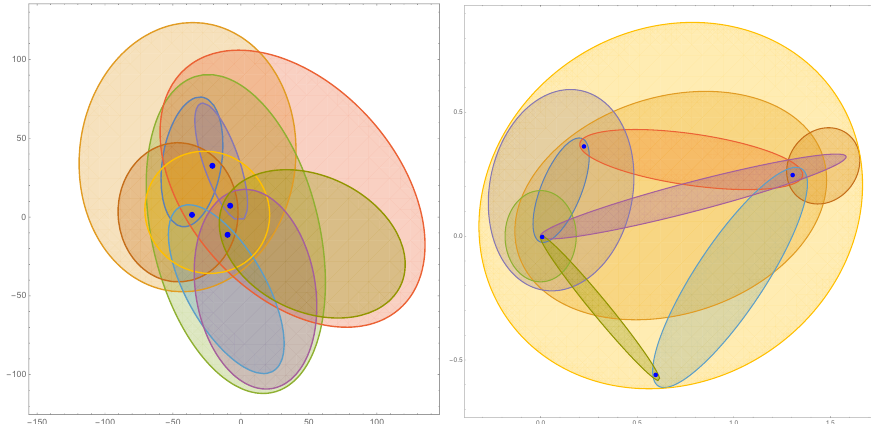
Figure 19. The singular E-surfaces from the two six-point one-loop integrals 1. 1L6P.VII (left) and 1. 1L6P.VIII (right) with di(cid:11)erent kinematics yielding drastically di(cid:11)erent maximally overlap- ping regions. In both cases our construction of the deformation is generated from the combination of four radial (cid:12)elds with sources indicated by blue dots. Additional support sources can potential improve on the worse convergence of integral 1. 1L6P.VIII